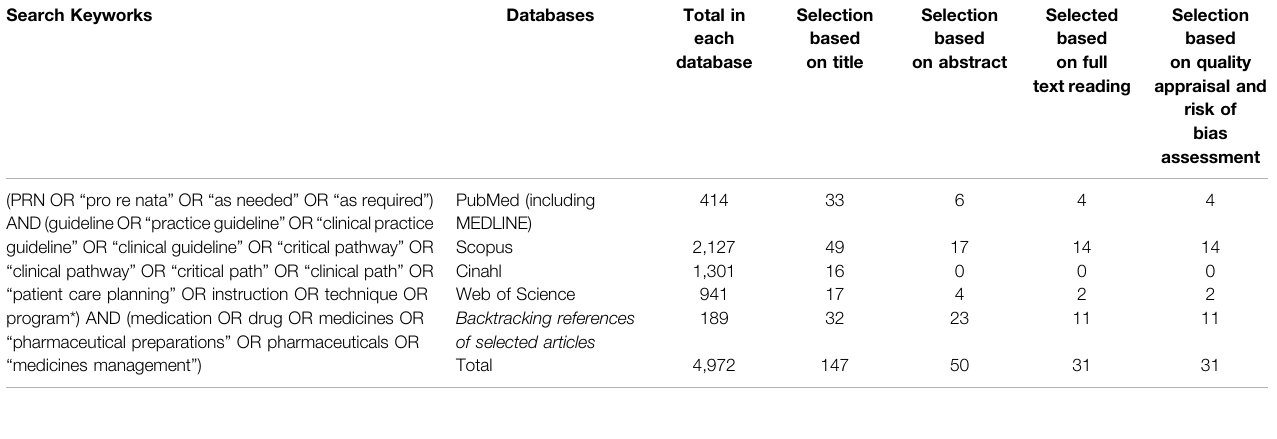
TABLE 1 | The result of search process.